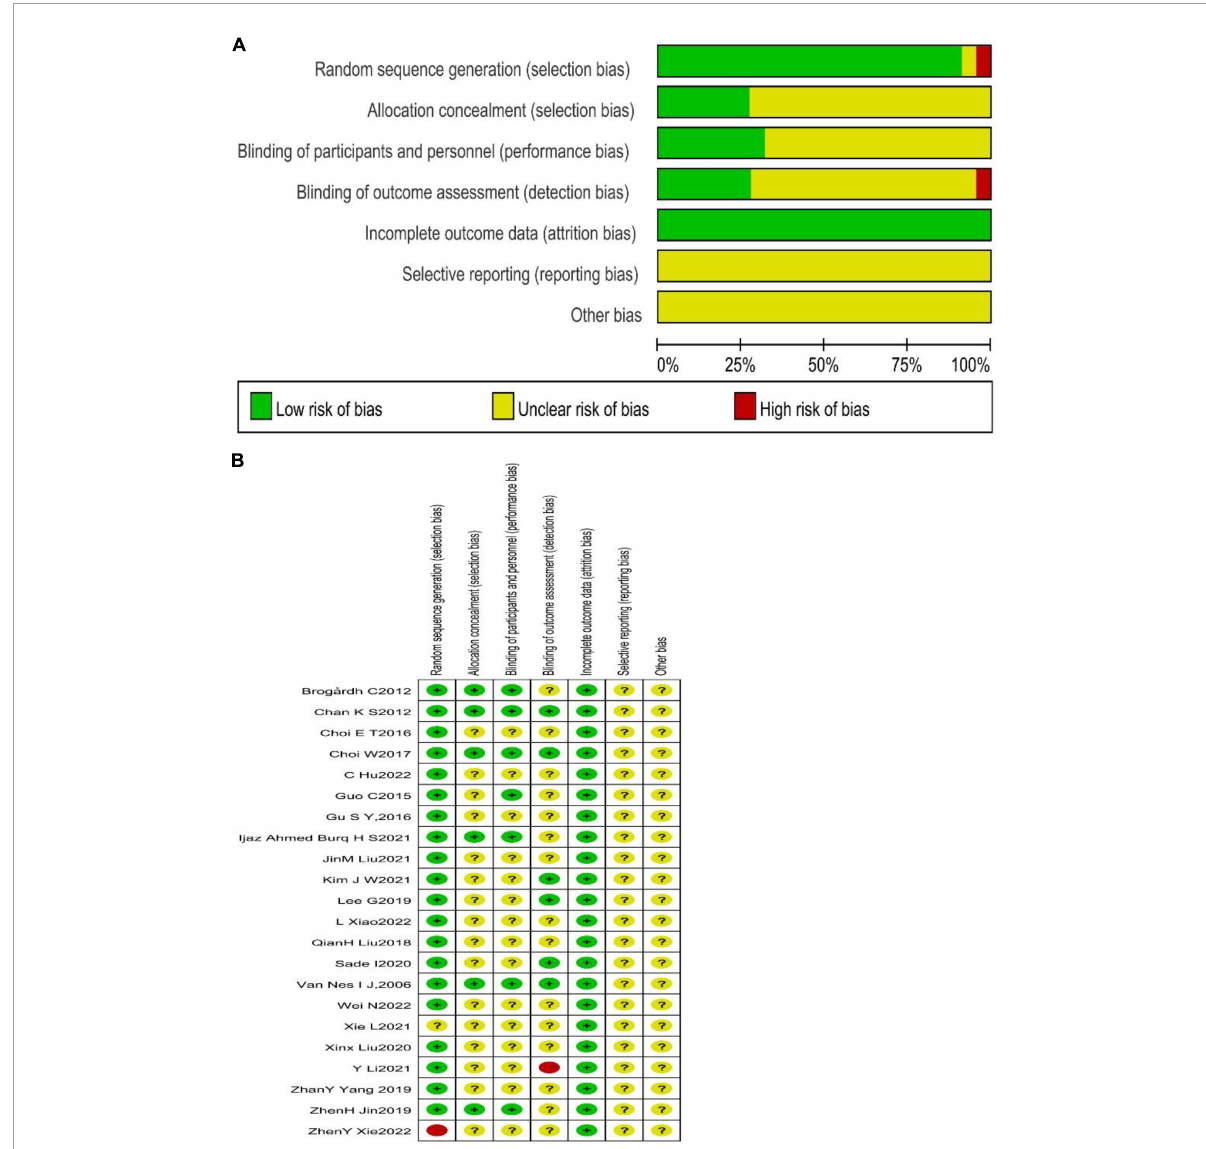
FIGURE2 The risk assessment of bias by Cochrane. (A) This figure summarized the quality assessment of all included studies and presented an overall study quality assessment and risk of bias. Green means low risk of bias, red means high risk of bias, and yellow means ominous risk of bias. (B) This figure was presented separately for each included study and intuitively presented the quality assessment and risk of bias of each study. “+” Means low risk of bias, “–” means high risk of bias, and “?” means unknown risk of